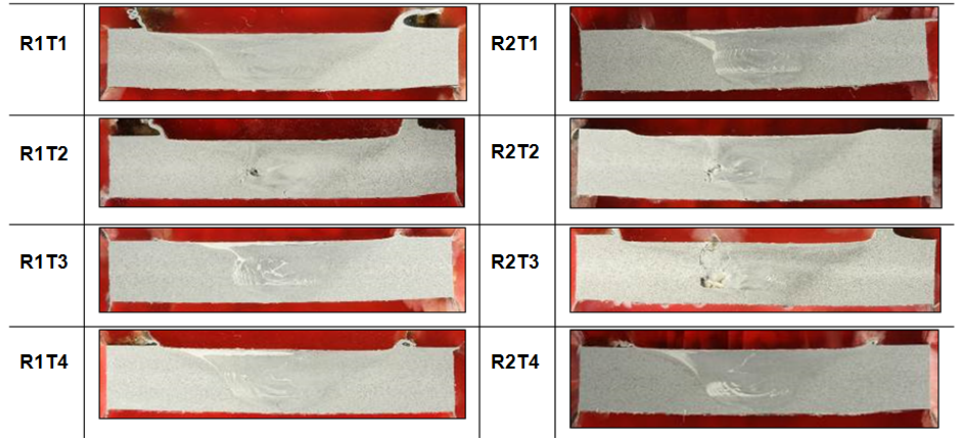
Figure 9. Macrographs of the cross section of the welds for the different welding parameters.